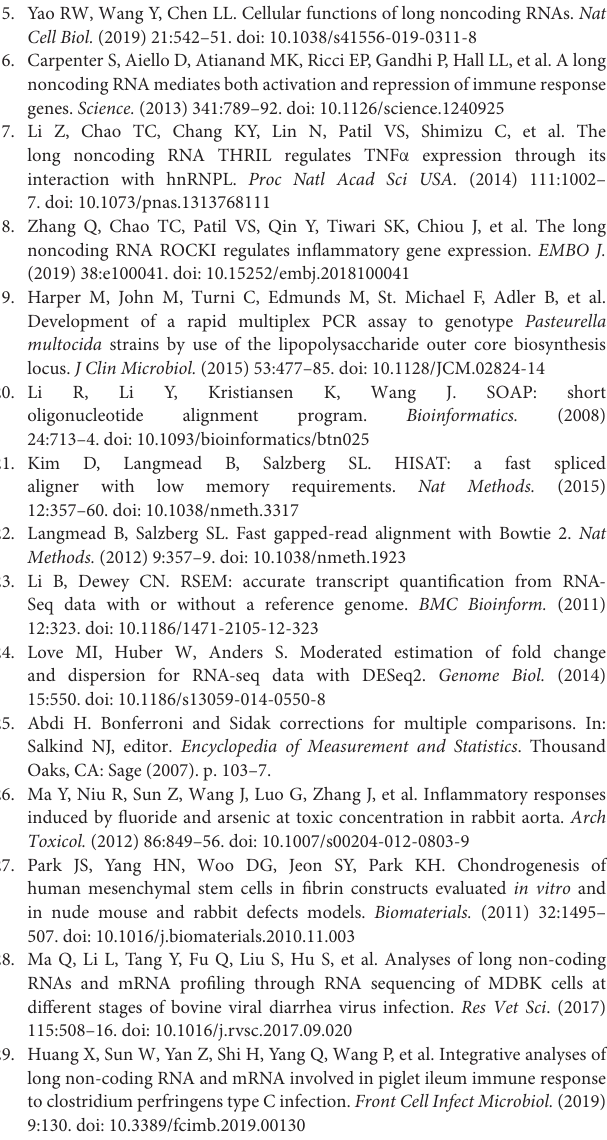
Supplementary Data Sheet 3 | Detailed information of the DE lncRNAs. Supplementary Data Sheet 4 | Detailed information of the DE mRNAs. Supplementary Data Sheet 5 | Detailed information of GO enrichment of DE mRNAs in the P0-vs-P1 group. Supplementary Data Sheet 6 | Detailed information of GO enrichment of DE mRNAs in the P0-vs-P3 group. Supplementary Data Sheet 7 | Detailed information of GO enrichment of DE mRNAs in the P3-vs-P1 group. Supplementary Data Sheet 8 | Detailed information of KEGG enrichment of DE mRNAs. Supplementary Data Sheet 9 | Detailed information of the major immune-related signal